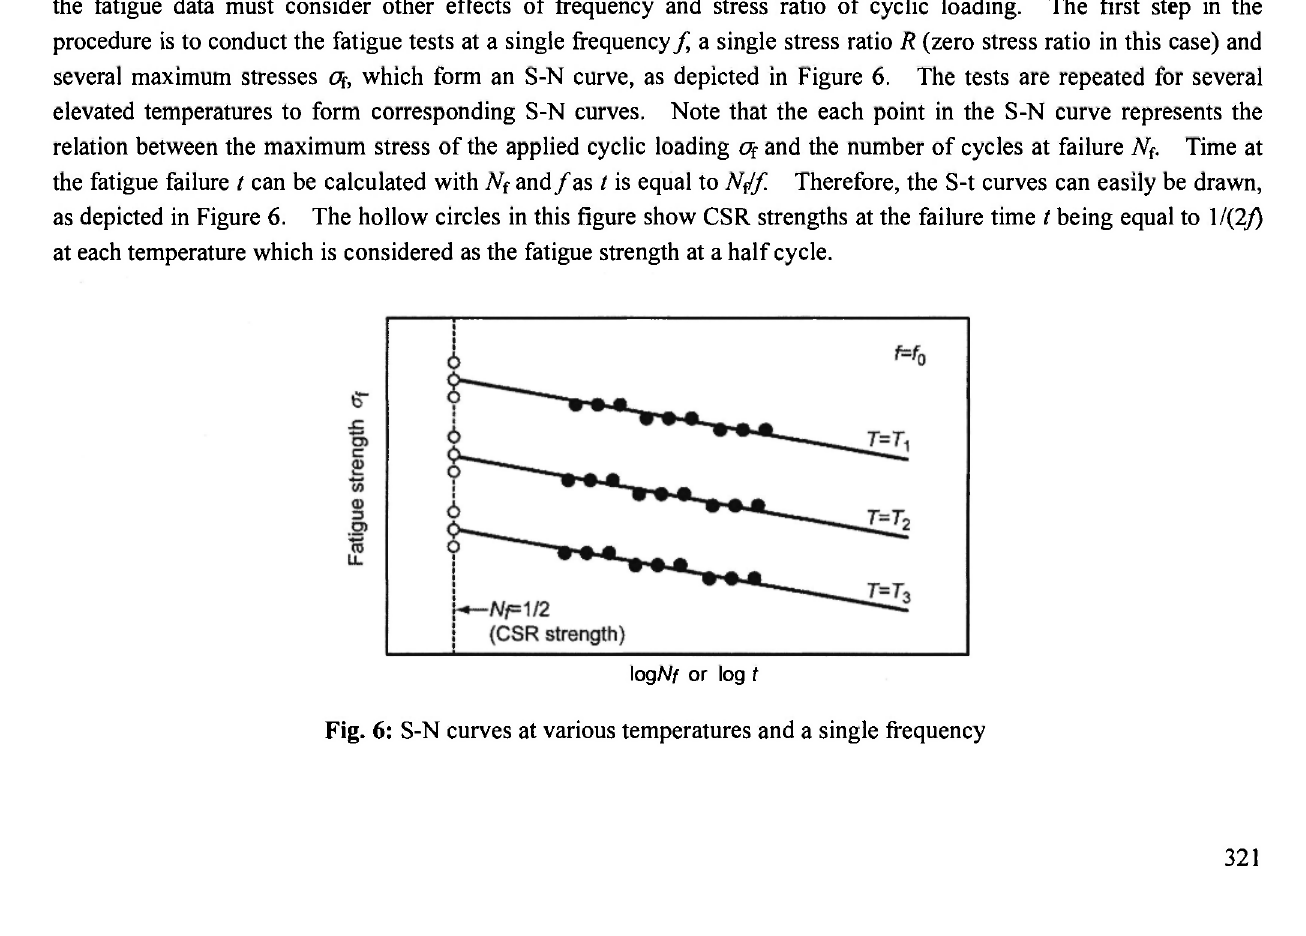
Fig. 6: S-N curves at various temperatures and a single